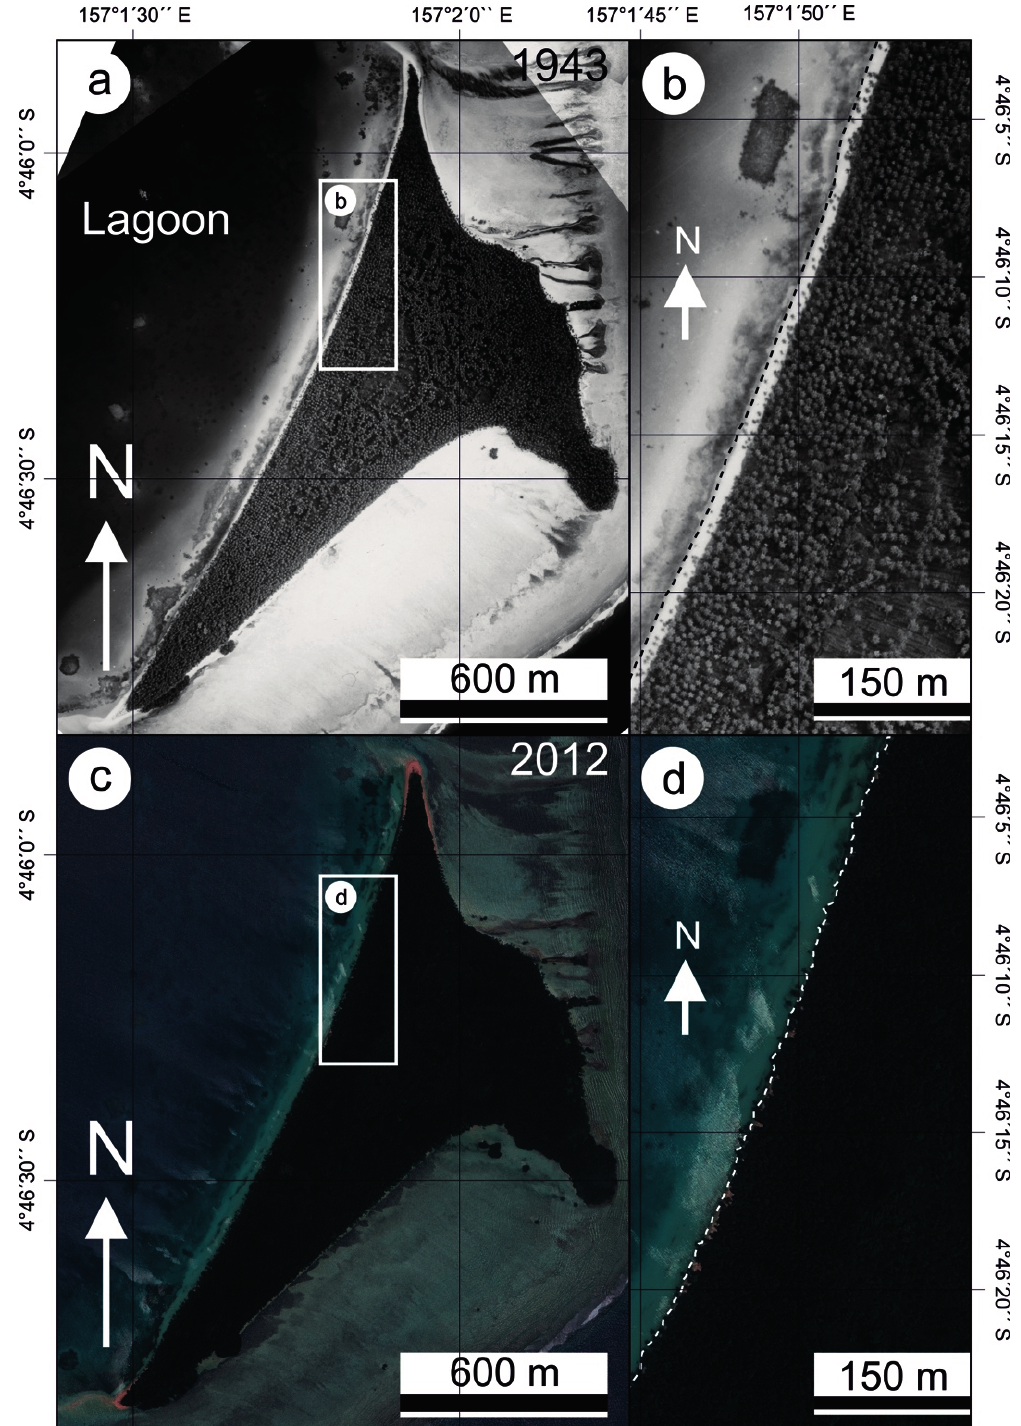
Figure 7. Takú Island in 1943 ( a , b ) and 2012 ( c , d ). A comparison, especially of the close-ups (b and d) reveals a reduction of beach width along the lagoonward shore. Aerial photograph (a) was provided by the Bernice Pauahi Bishop Museum (www.bishopmuseum.org), satellite image ( c ) is © DigitalGlobe, supplied by European Space